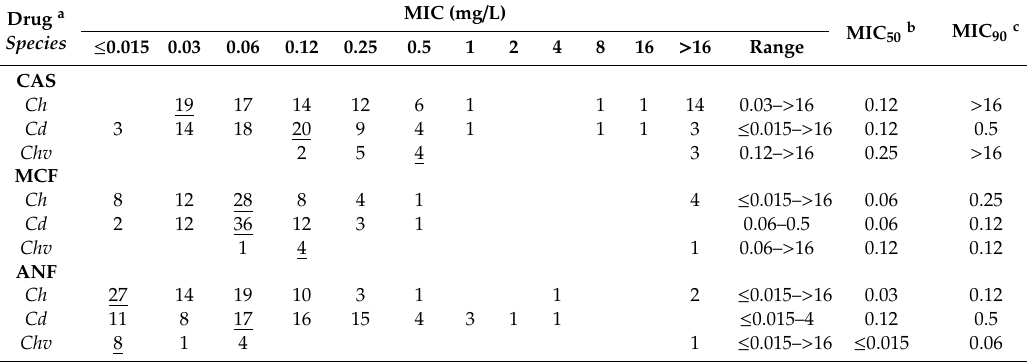
Table 4. MIC distribution of C. haemulonii complex isolates obtained from the literature review against the three echinocandins.